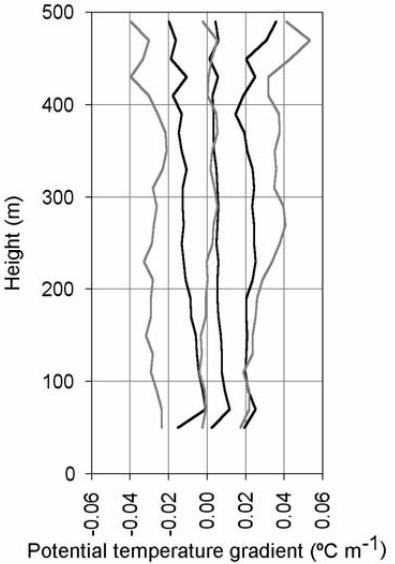
Fig. 2. First, second and third quartiles for vertical wind speed dur- ing the day (in grey) and night (in black).